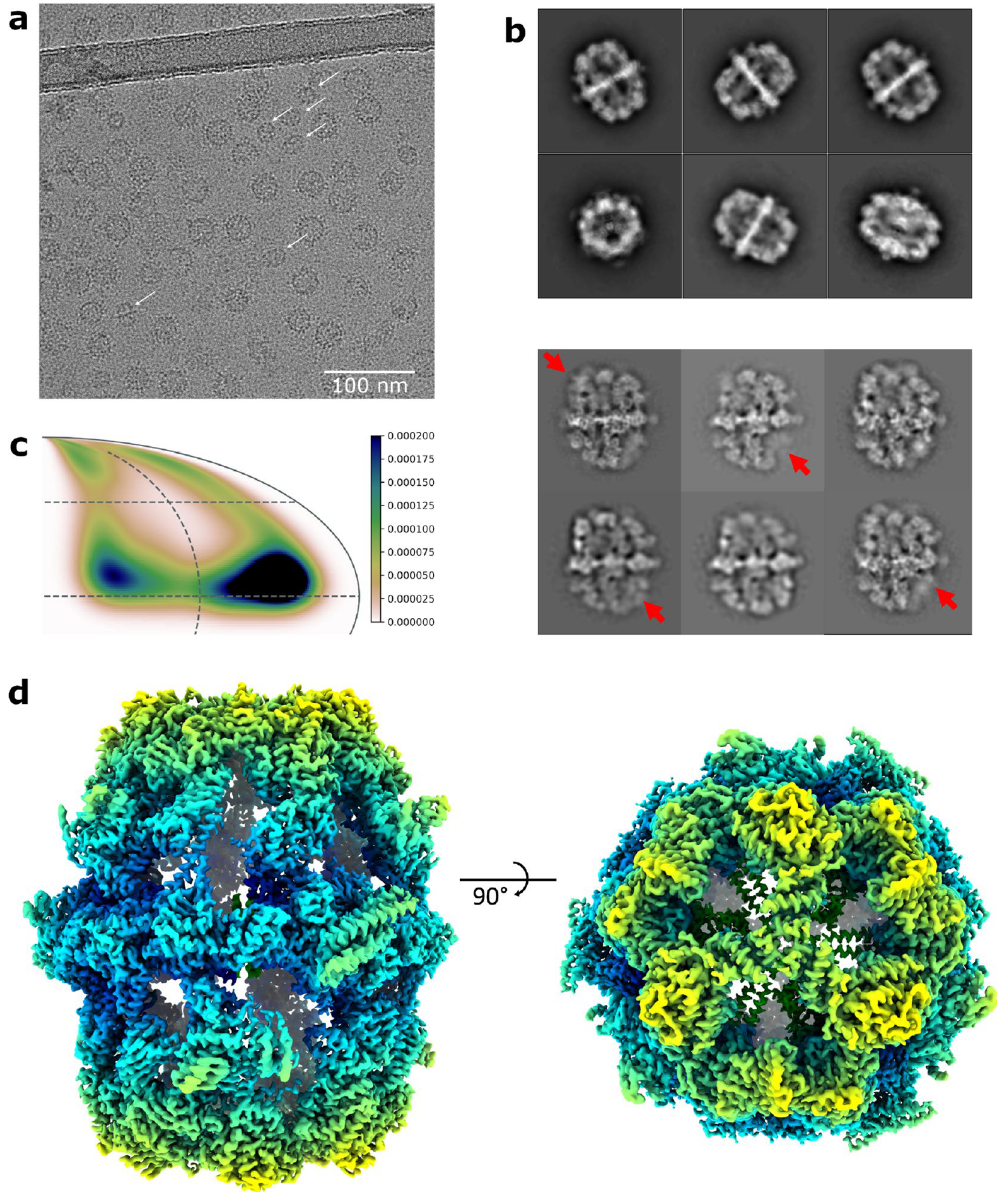
Figure 1. Determination of P. pastoris FAS structure by cryoEM. ( a ) Raw micrograph showing VLPs with contaminating FAS particles. FAS particles are indicated by white arrows. Scale bar shows 100 nm. ( b ) The most populated classes from 2D classification of P. pastoris FAS using a box size of 460 pixels (after excluding ‘junk’ classes of FAS over thick carbon support) (upper) compared with 2D class averages of S. cerevisiae FAS showing partial denaturation (indicated by red arrows) from D’Imprima et al. (2019) 19 (licensed under CC BY 4.0) (lower). ( c ) Orientation distribution map of particles contributing to the final reconstruction of the FAS asymmetric unit. The map shows the probability that any particle was assigned the orientation indicated, according to the scale shown. ( d ) CryoEM density map of P. pastoris FAS, coloured